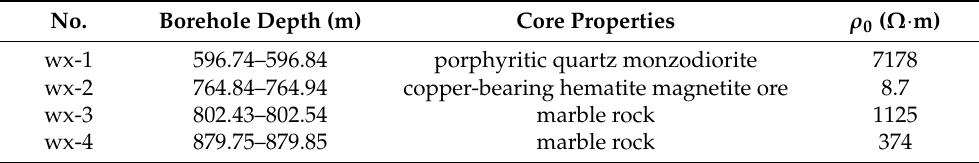
Table 1. Resistivities of rock samples from borehole